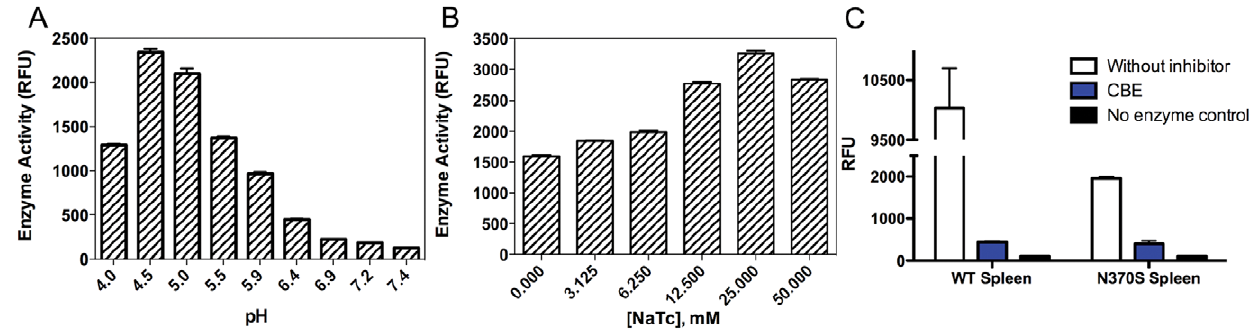
Figure 3. Characterization of spleen GCase activity. A. pH optimum, B. NaTC dependency, C. Inhibition of spleen GCase activity by CBE.